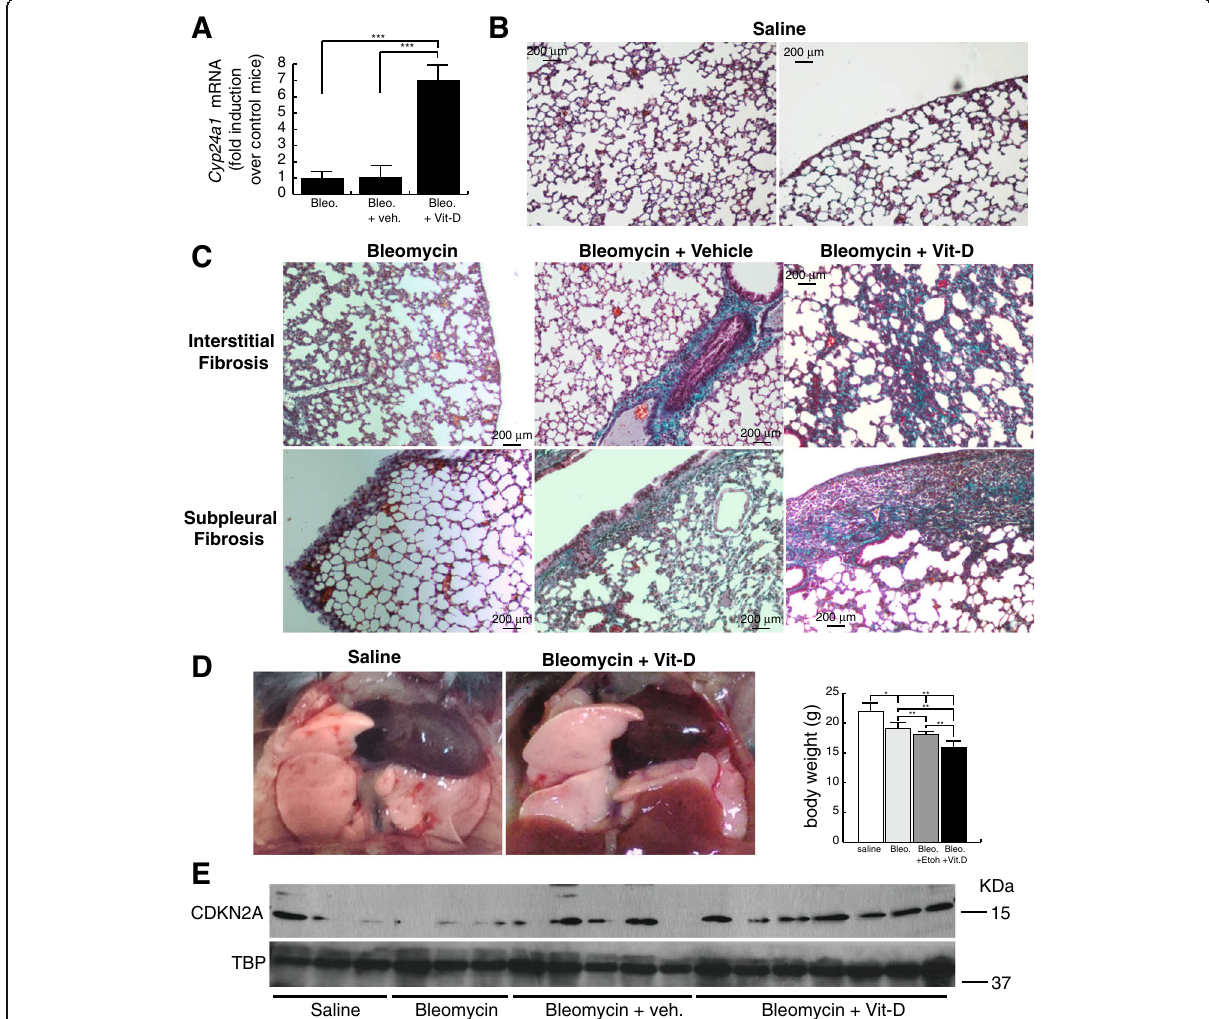
Fig. 7 Vitamin D exacerbates lung fibrosis in mice. a Expression of liver Cyp24a1 . Values are folds of induction over control mice (treated with bleomycin vehicle: saline); veh.: vitamin D vehicle. The results presented in the figures are means ± SEM. Significance of the analysis is indicated as ***, P < 0.001. b Representative micrographs of Masson ’ s stain of lung sections from control mice (treated with bleomycin vehicle: saline). Scale bar: 200 μ m. c Representative micrographs of Masson ’ s stains of lung sections of mice treated with bleomycin and vitamin D or its vehicle. Scale bar: 200 μ m. d Representative macrographs of lungs from control mice and treated with bleomycin and vitamin D. Right panel: body weights